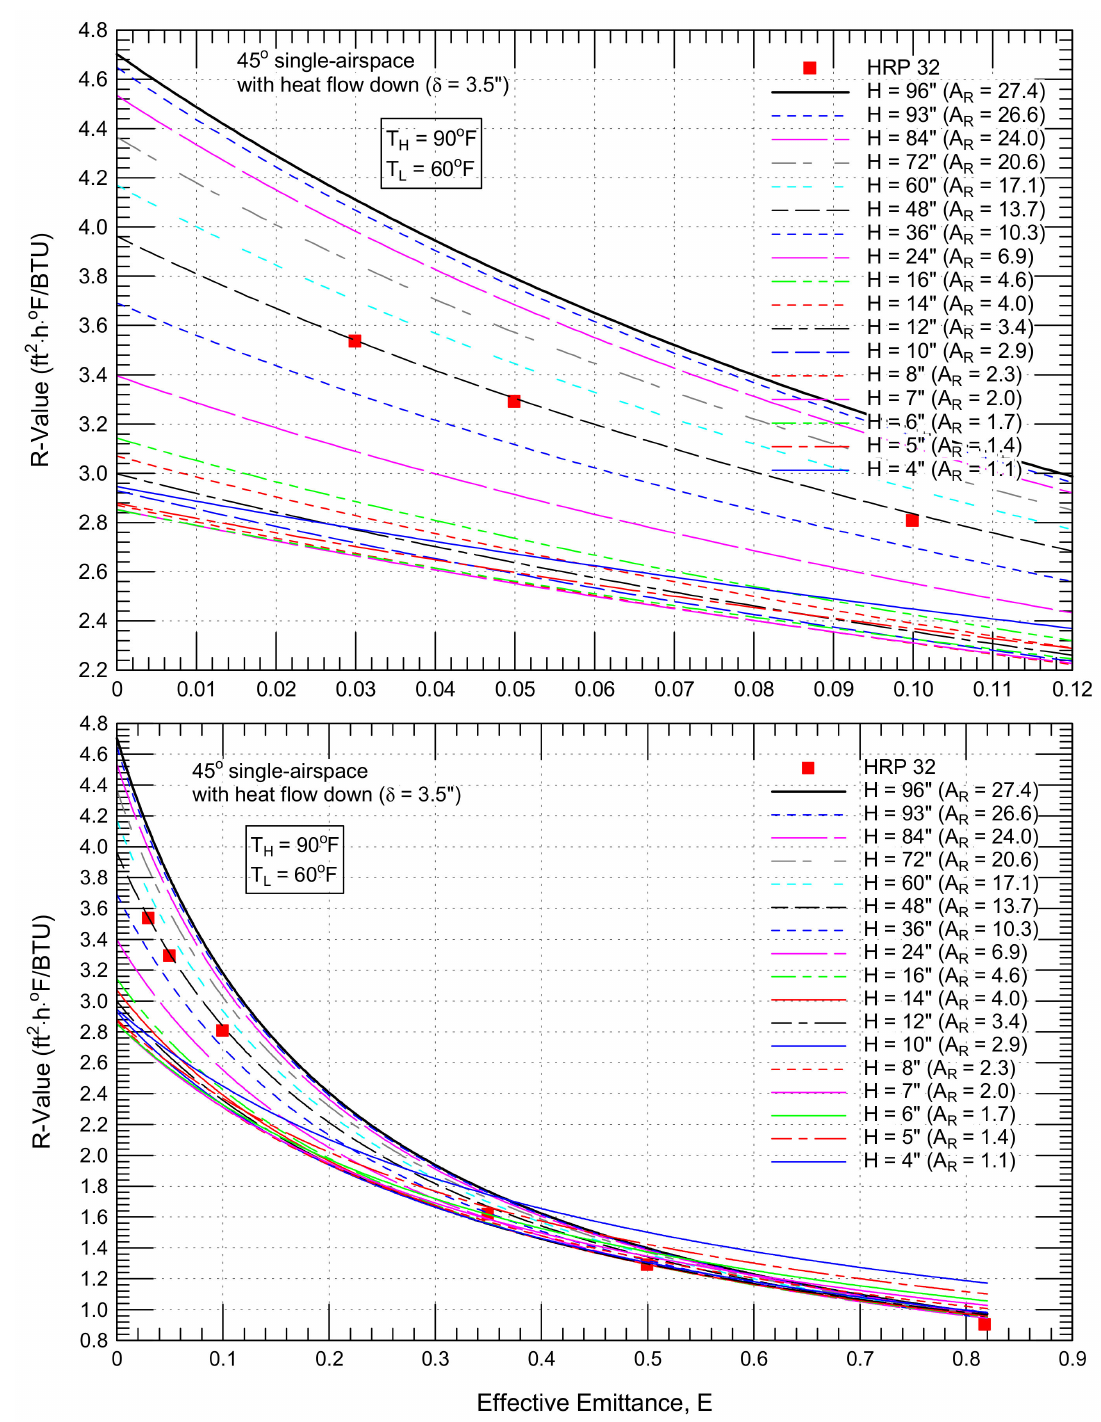
Figure 16. Comparisons of R values of HRP 32 [4] with present model predictions of various A R for a sloped single airspace subjected to a downward heat flow ( θ = 45 ◦ , total δ = 3.5 inches, T H = 90 ◦ F, T L = 60 ◦